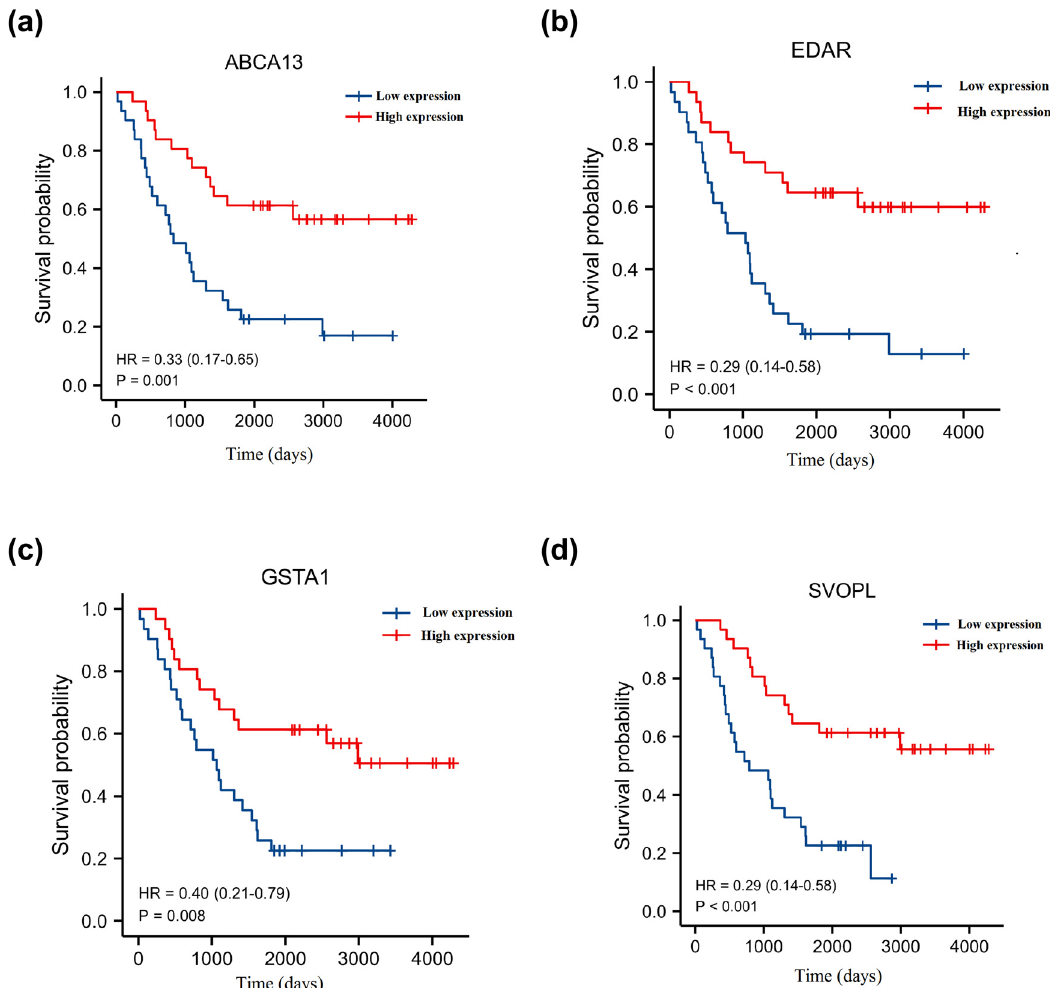
Figure 4: Kaplan – Meier progression - free survival ( PFS ) analysis of ( a ) ABCA13, ( b ) EDAR, ( c ) GSTA1, and ( d ) SVOPL in breast